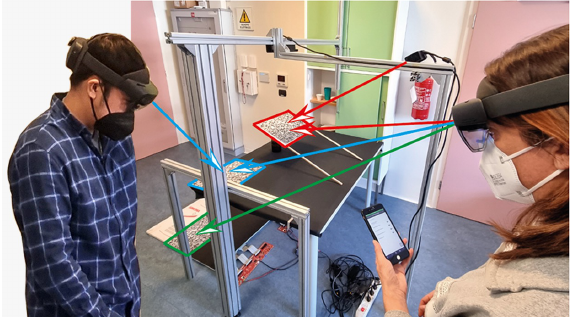
Figure 4. Spatial Anchors setting: the red image target is used by the therapist’s HoloLens and the Kinect to operate in the same reference system; the blue target is used by the therapist’s and the patient’s Hololens to have the same reference system of the working plane; the green target is used only by the therapist’s HoloLens to localize the baropodometric platform in